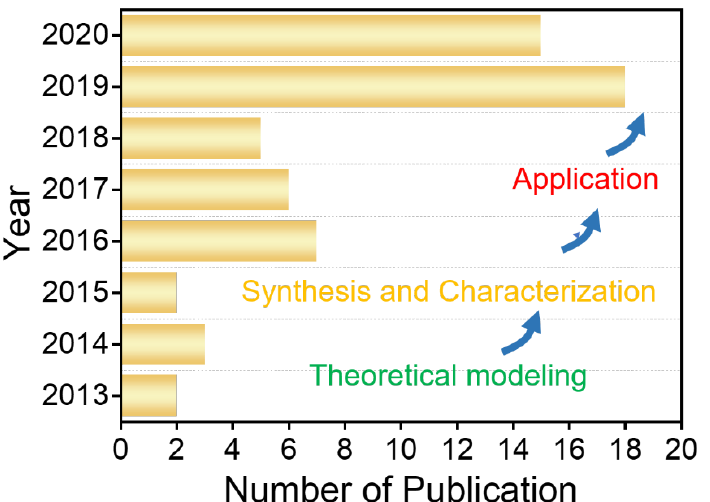
Figure 1. The number of papers published with title or topic containing boron nitride quantum dots (BNQDs) based on Web of Science TM analysis with the keyword “boron nitride quantum dots”.